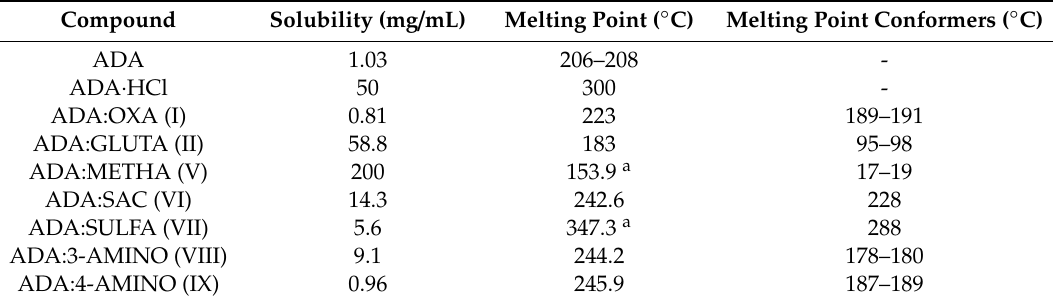
Table 3. Solubility, thermal stability, in ADA, ADA · HCl, and molecular salts [76]. Compound Solubility (mg / mL) Melting Point ( ◦ C) Melting Point Conformers ( ◦ C) ADA